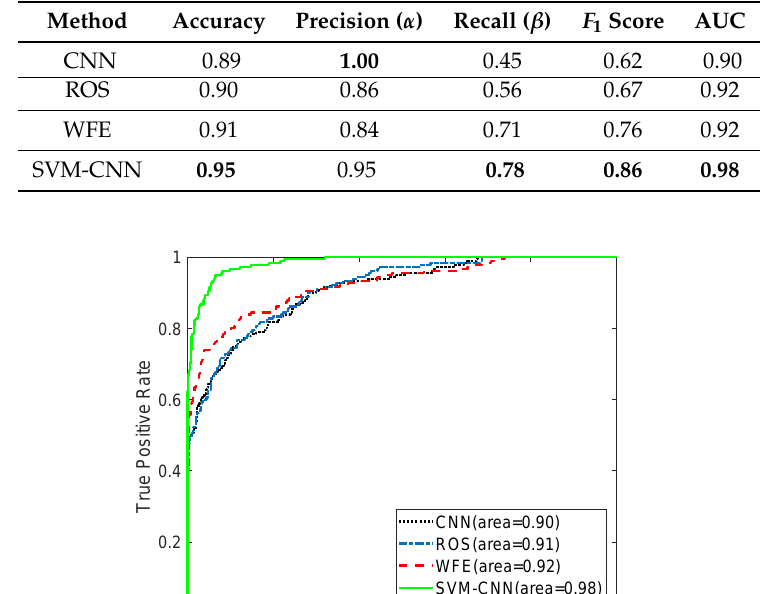
Table 6. Classification result comparisons in the mixed dataset. Bold values denote the highest one in each attribute.